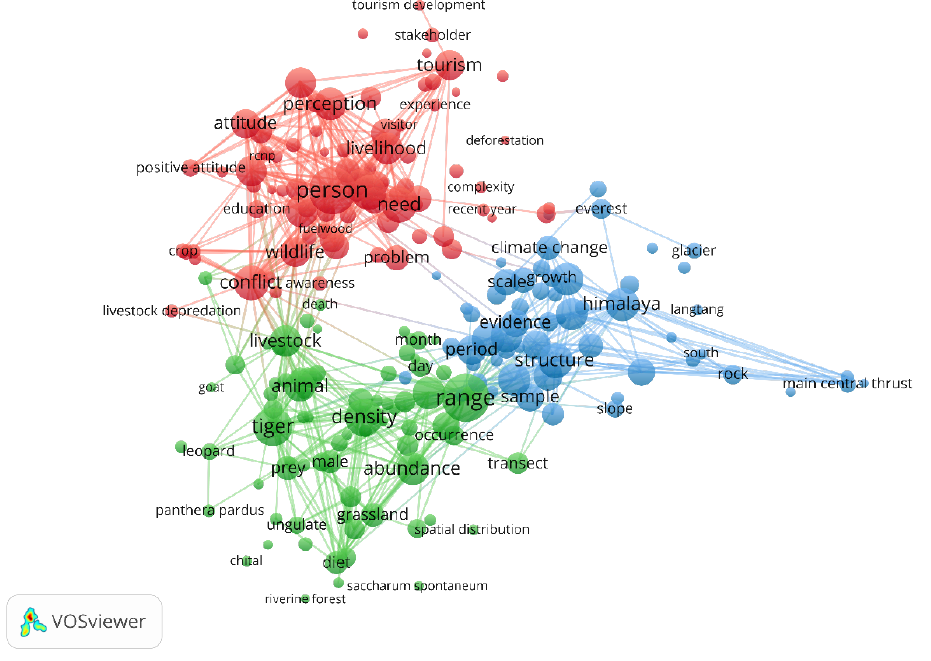
Figure 10. Mapping of “National Parks”.